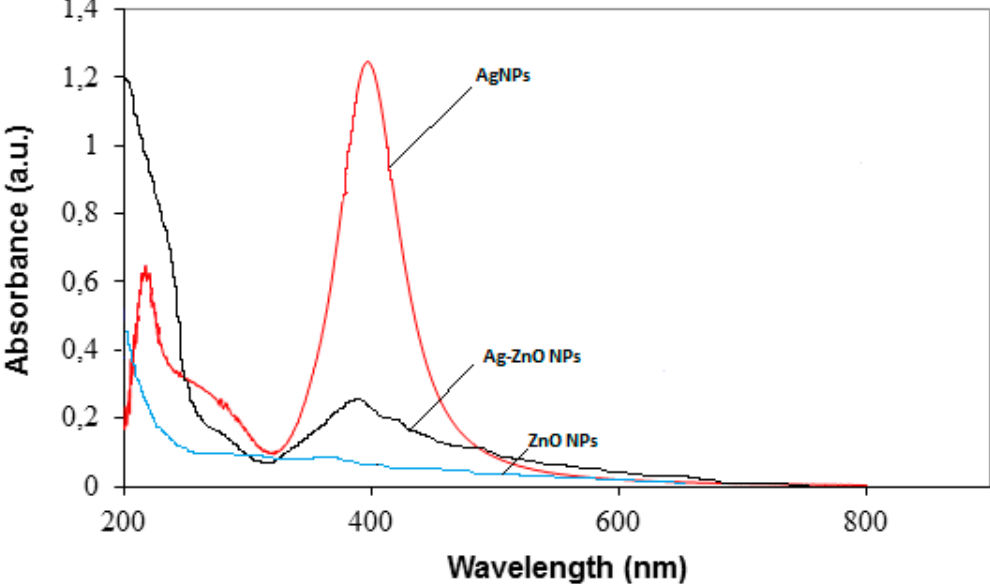
Figure 6. UV-Vis spectra of AgNP-decorated nano-ZnO particles (dispersed in water).